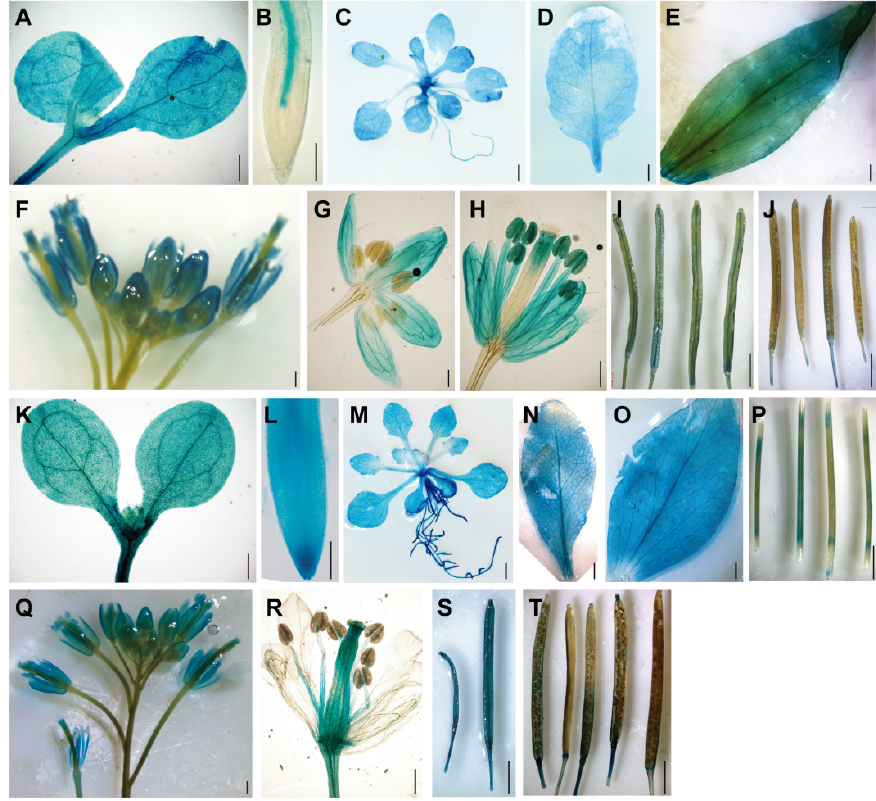
Figure 1. Expression patterns of the Arabidopsis BAG2 and BAG6 genes. ( A – J ) Expression of ProBAG2:GUS in 5-day-old seedlings cotyledons and hypocotyl ( A ), root tip ( B ), 2-week-old plant ( C ), rosette leaf ( D ), cauline leaf ( E ), inflorescence ( F ), flower bud ( G ), opened flower ( H ), young siliques ( I ), and mature siliques ( J ); ( K – T ) Expression of ProBAG6:GUS in cotyledons and hypocotyl ( K ) and root tip ( L ) of 5-day-old seedling, 2-week-old plant ( M ), rosette leaf ( N ), cauline leaf ( O ), stems ( P ), inflorescence ( Q ), opened flower ( R ), young siliques ( S ), and mature siliques ( T ). Bars = 100 μm in ( B , L ), 400 μm in ( A , F – H , K , Q – R ) and 2 mm in ( C – E , I – J , M – P , S – T ).